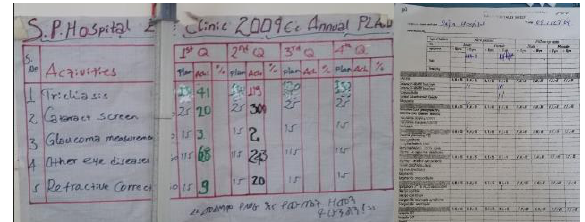
Figure 6. Paper forms for recording and reporting the number of different types of eye